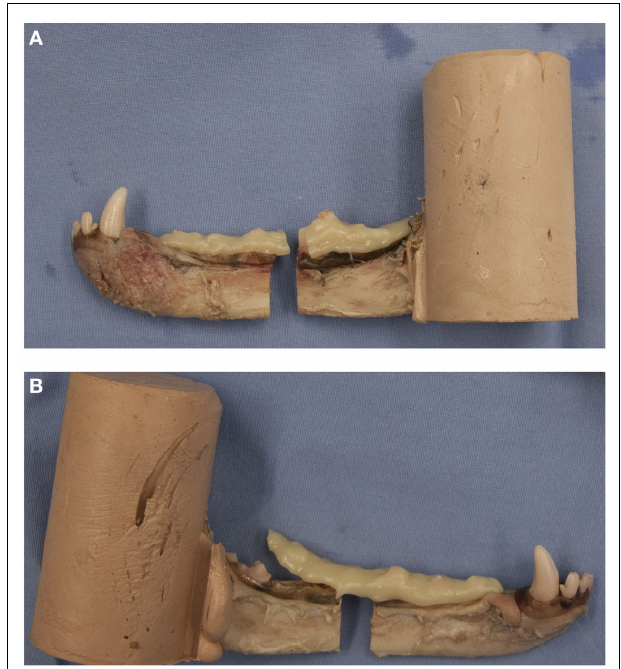
FIGURE 4 | Examples of a pair of potted hemi-mandibles receiving composite-only treatments . The left mandible (A) received composite fixation and demonstrates cohesive failure of the fixation device. The right mandible (B) received crown removal and demonstrates adhesive failure of the fixation